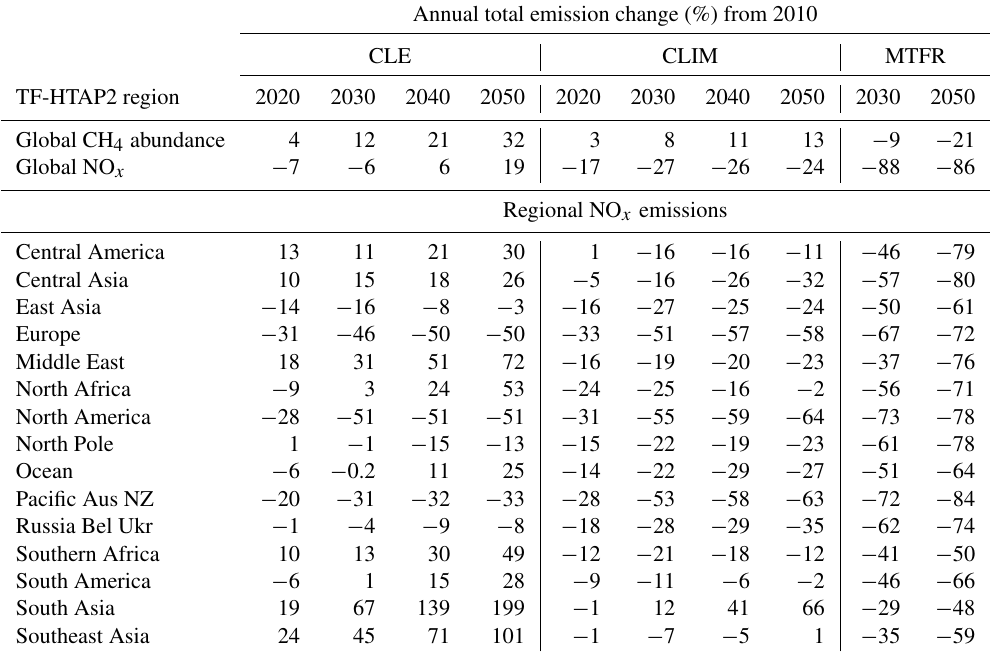
Table 4. Percentage change in global CH 4 abundance and global and regional annual NO x emissions relative to 2010 over each TF-HTAP2 region for the different ECLIPSE V5a emission scenarios (CLE, CLIM and MTFR). MTFR scenarios are only available for 2030 and 2050.